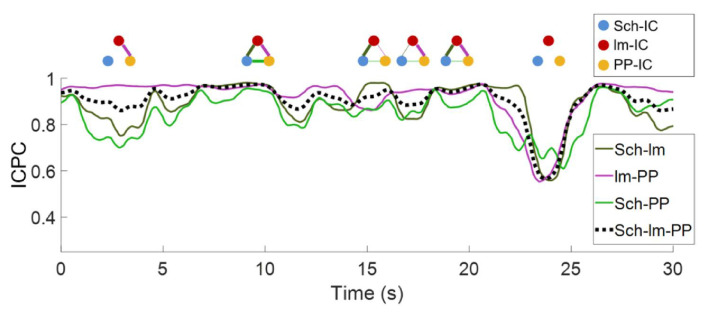
Representative values of ICPC in one animal along time.The dashed line represents the ICPC computed between the three IC-LFPs, while color-coded curves are the ICPC between pairs of IC-LFPs. A schematic diagram of the connectivity at specific time points is shown at the top, where the thickness of the lines represents the ICPC value between pairs. For clarity, epochs of lower ICPC are represented as nodes without links.